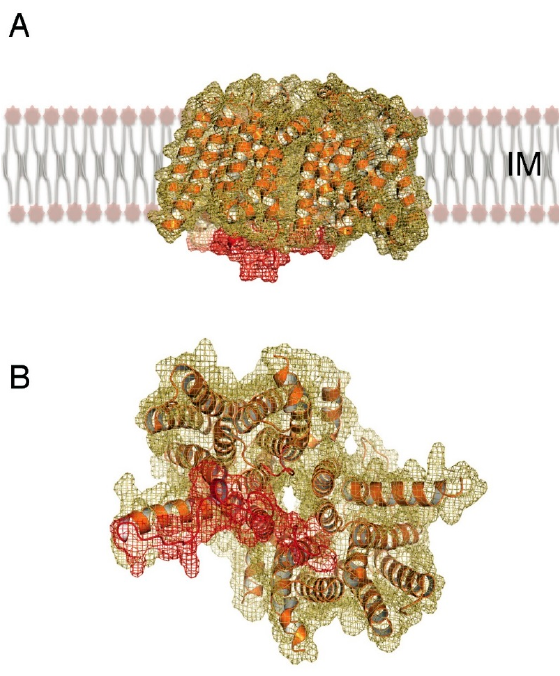
Figure 2. The crystal structure of MraY from Aquifex aeolicus (PDB 4J72) reveals ( A ) a dimer displaying 10 TM helices per monomer, whose N- and C-termini face the periplasm. ( B ) A view from the cytoplasmic side indicates a tunnel formed in the monomer-monomer interaction region, buttressed by cytoplasmic loops (in red) that could interact with substrate, partner proteins, or